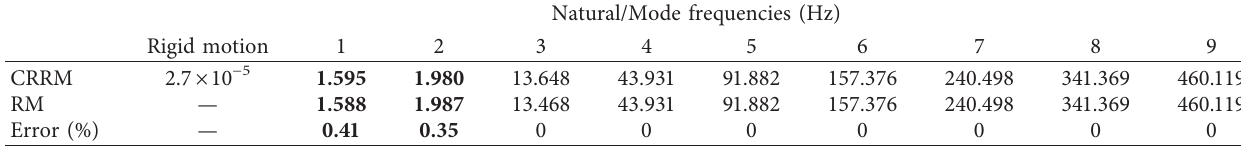
Table 5: Natural frequencies of the corrected RRM (CRRM) compare reduced model